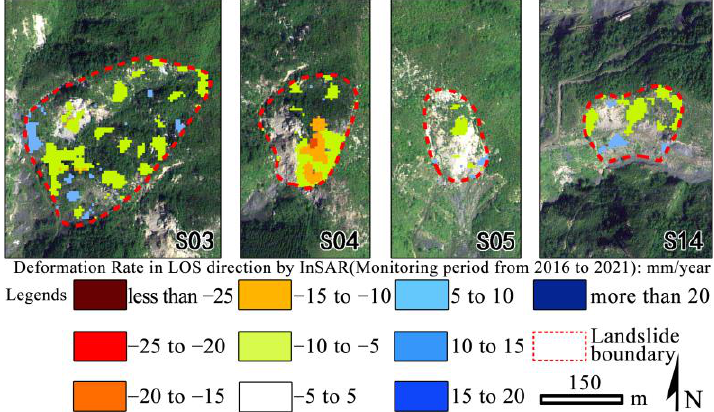
Figure 6. InSAR time series results of landslide S03, S04, S05 and